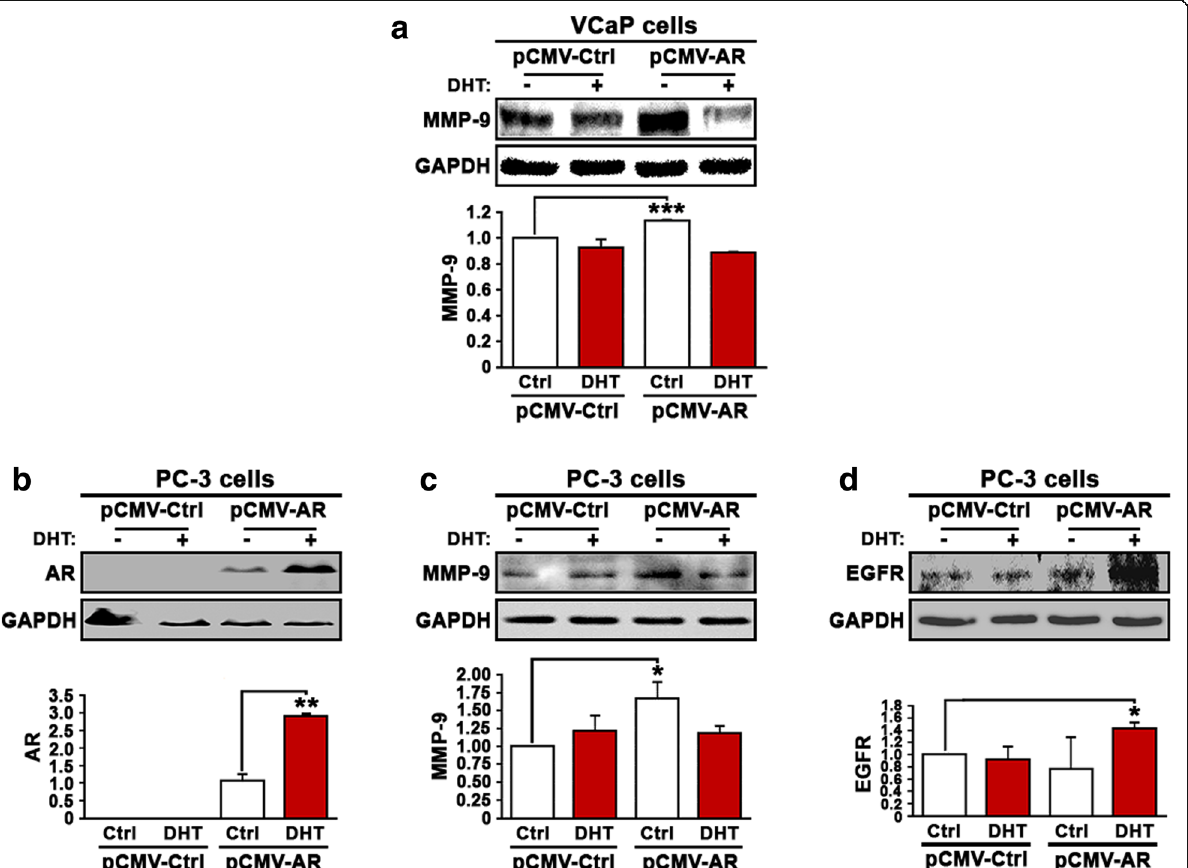
Fig. 4 Evaluation of the effect of overexpression of AR in the presence or absence of DHT treatment on MMP-9 and EGFR expression in PCa cells. a Immunoblot analysis was performed to examine the expression of MMP-9 in VCaP cells that were transfected with pCMV control or pCMV-AR vectors followed by treatment with DHT or vehicle control. b Immunoblot analysis on the expression of AR in PC-3 cells that were transfected with pCMV control or pCMV-AR vectors followed by treatment with DHT. c Immunoblot analysis on the expression of MMP-9 in PC-3 cells that were transfected with pCMV control or pCMV-AR vectors followed by treatment with DHT. d Immunoblot analysis on the expression of EGFR in PC-3 cells that were transfected with pCMV control or pCMV-AR vectors followed by treatment with DHT. Data presented is the average of at least two independent experiments (±SD). p < 0.05 is indicated by “ * ” , p ≤ 0.01 is indicated by “ ** ” , p ≤ 0.001 is indicated by “ ***